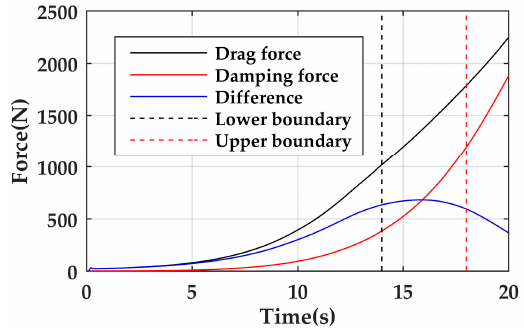
Figure A3. Difference force in group 1.